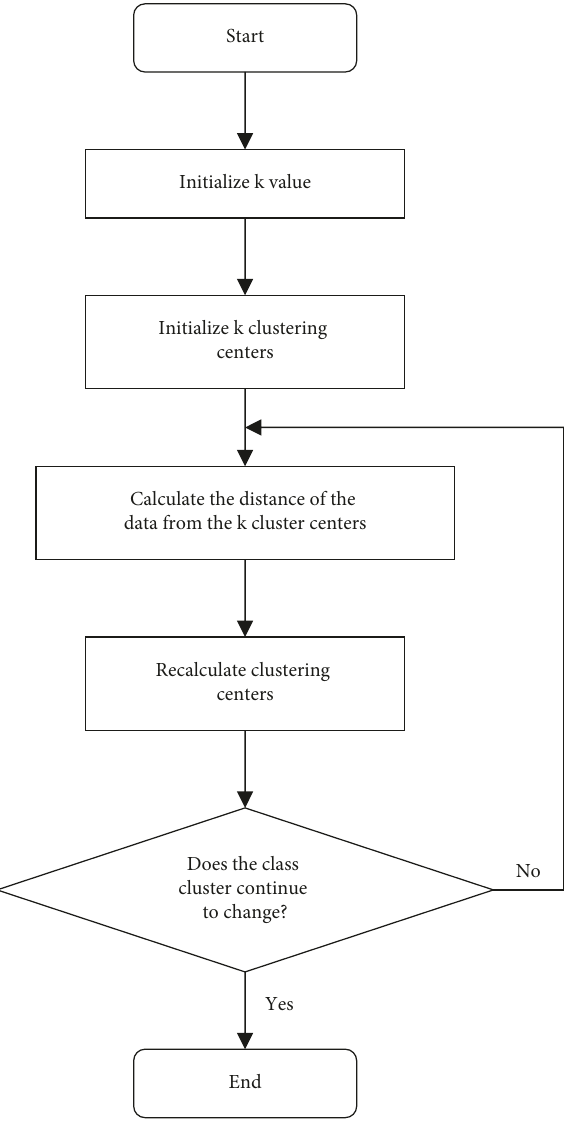
Figure 2: Detailed process of the K-means